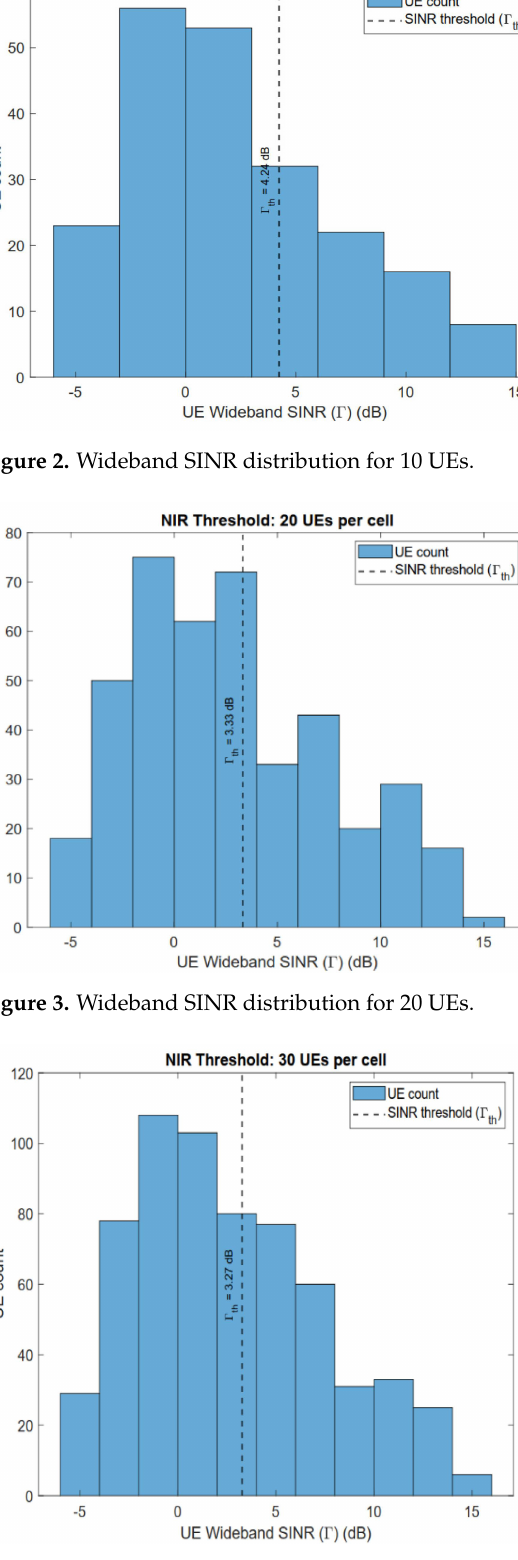
Figure 4. Wideband SINR distribution for 30